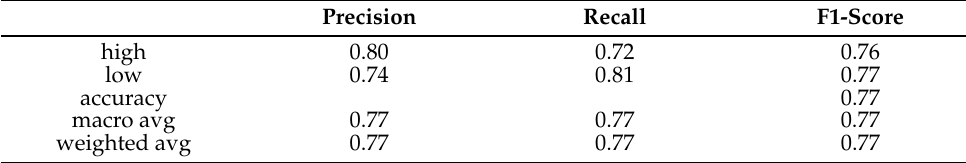
Figure 8. Confusion matrix, accuracy, and loss function for the total dataset for two levels of fear of fall (low vs. high). Table 10. Performance metrics for two classes of FOF (low vs. high) for the total dataset.